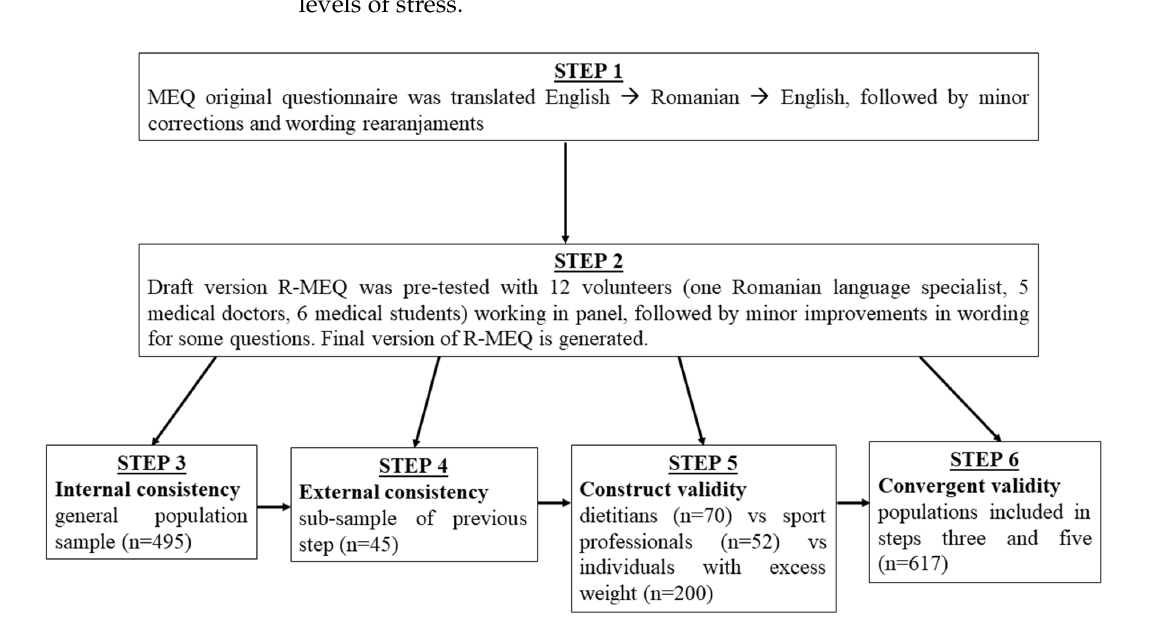
Figure 1. Flow diagram for the steps and populations used in reliability and validity testing of MEQ in a Romanian adult population.